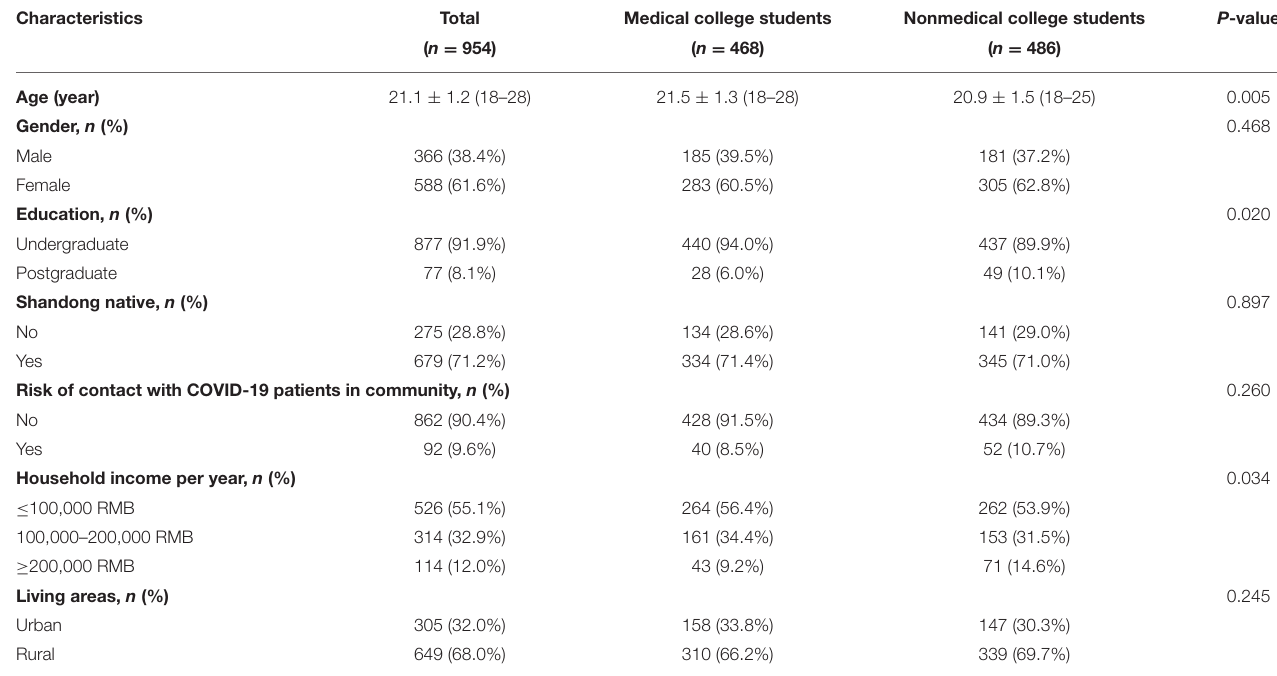
TABLE 1 | Sociodemographic characteristics in medical college students vs. nonmedical college students.